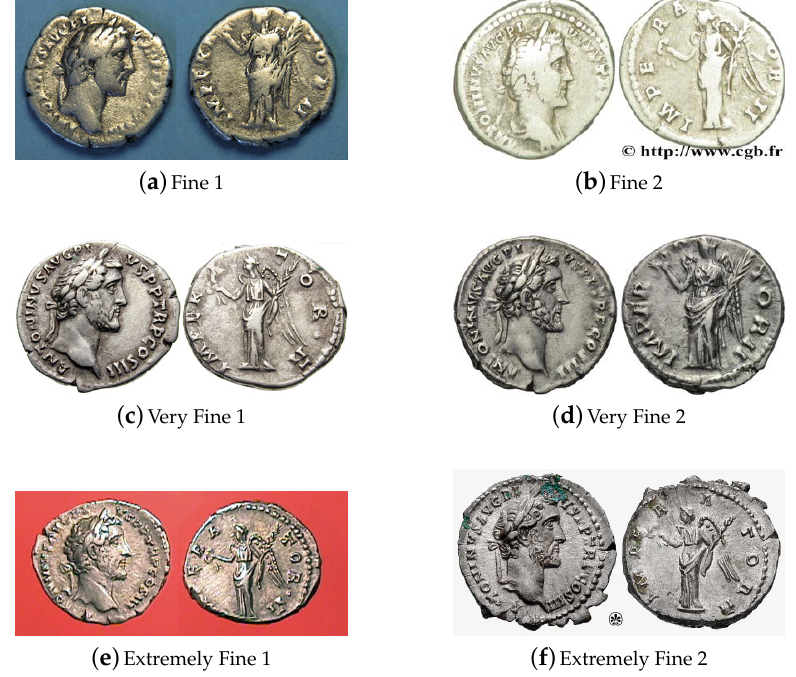
Figure 8. Our data set entry for Antoninus Pius Denarius RIC 111—there are images of two specimens for each of the three conditions included for all denarii issues in the data set (F, VF, and